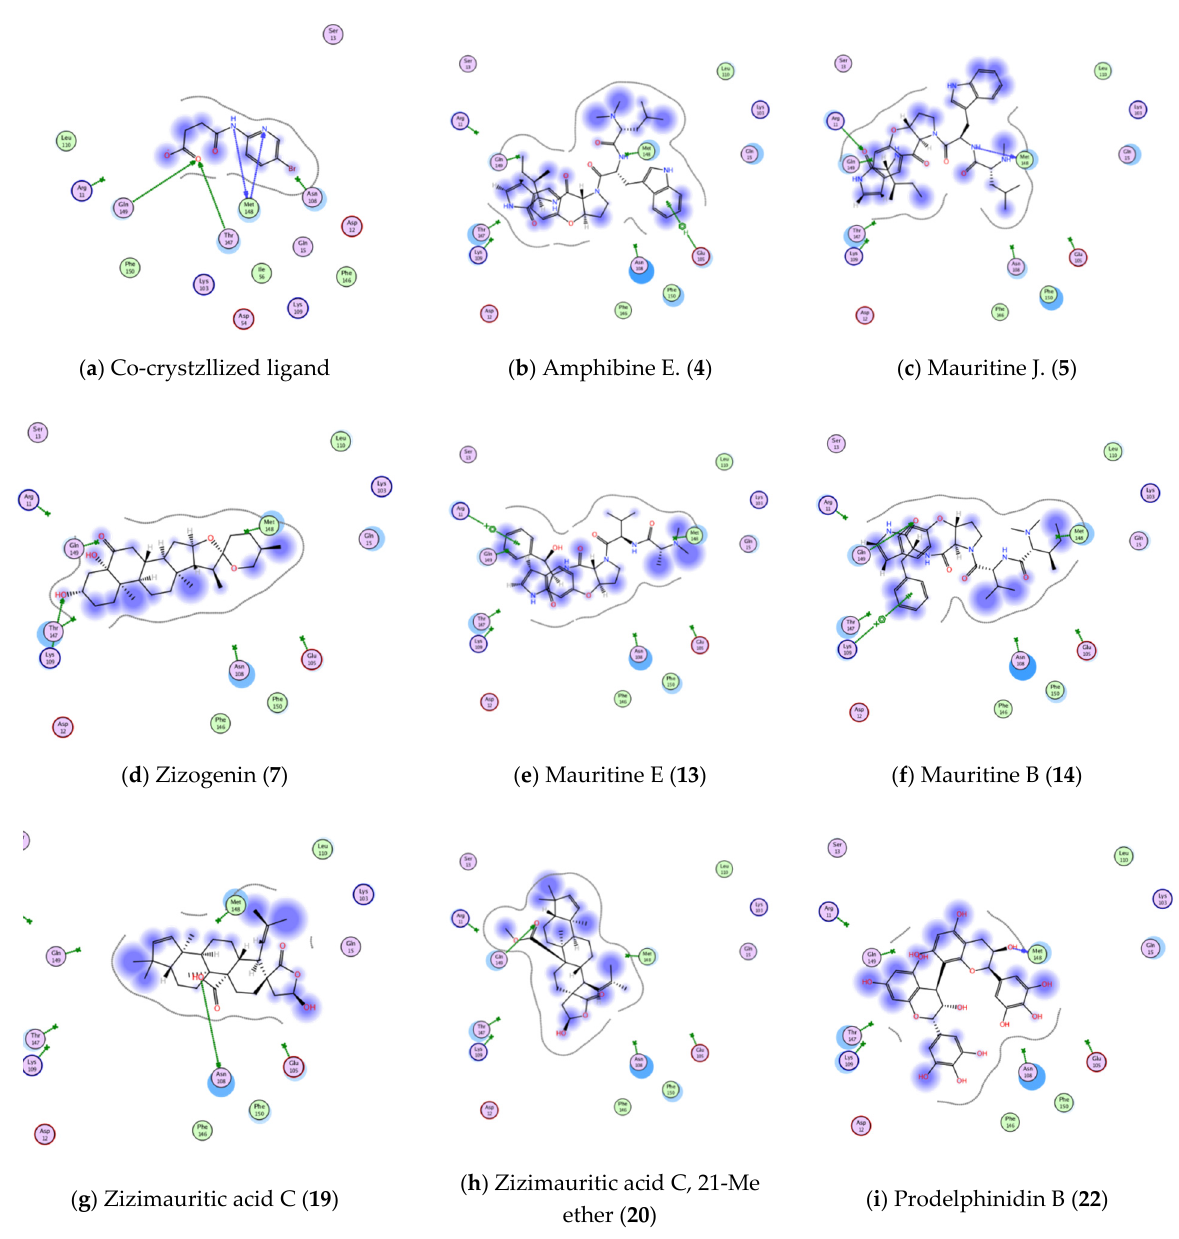
Figure 13. Showing 2D-binding interactions of co-crystallized ligand ( a ) and molecules 4 , 5 , 7 , 13 , 14 , 19 , 20 , 22 (( b )–( i ), respectively) within active sites of Interleukin 1 β (PDB ID: 6Y8M). Table 5. Interaction binding energy (S; kcal/mol) and binding accuracy (RMSD; Å) of